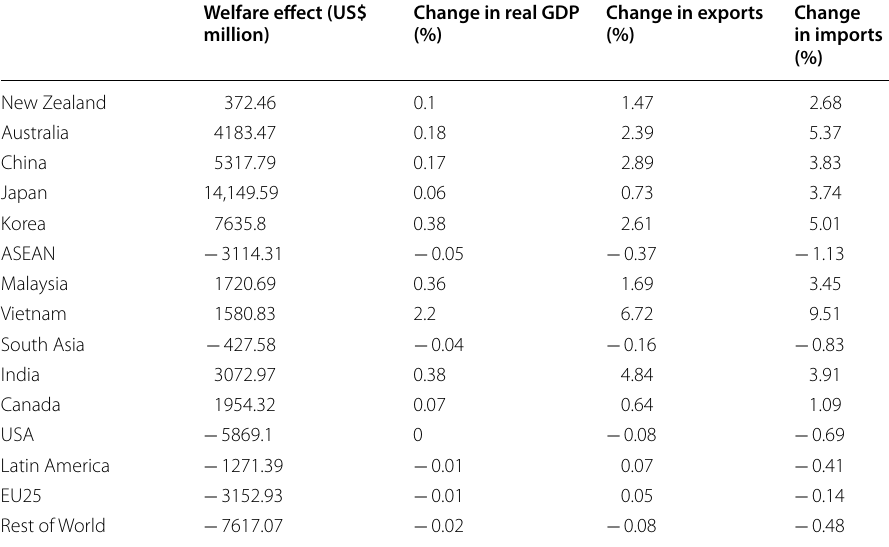
Table 8 Macroeconomic of tariff elimination under ‘Indo-Pacific 3’. Source: Authors’ simulation from GTAP version